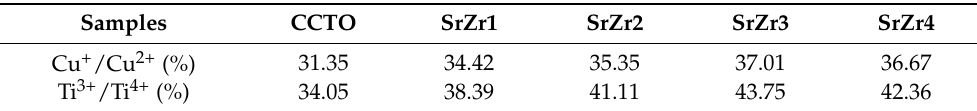
Table 2. Fitting results of XPS Cu 2p 3/2 spectra and Ti 2p 3/2 spectra for CCTO, SrZr1, SrZr2, SrZr3, and SrZr4 ceramics.